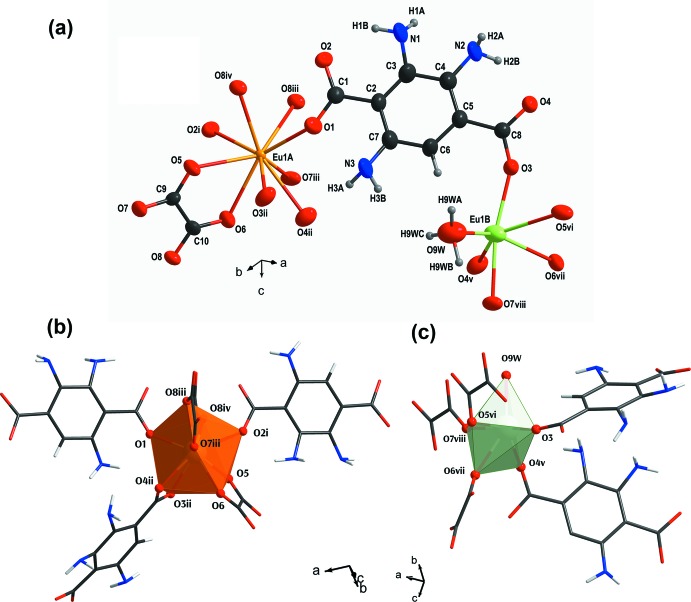
Views of (a) an extended asymmetric unit of I drawn using 60% probability ellipsoids and the coordination environments about (b) Eu1A and (c) Eu1B. [Symmetry codes: (i) −x, 1 − y, −z; (ii) 1 − x,  + y,  − z; (iii) −x, − + y,  − z; (iv) x,  − y, − + z; (v) x,  − y,  + z; (vi) 1 − x, − + y,  − z; (vii) 1 − x, 1 − y, 1 − z; (viii) 1 − x,  − y,  + z.]